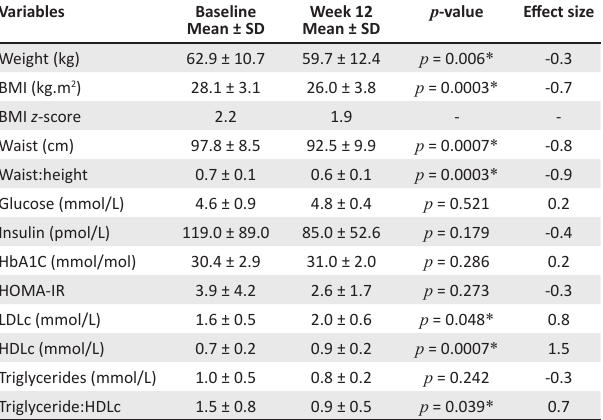
TABLE 3: Change in metabolic health markers of completing participants. Variables